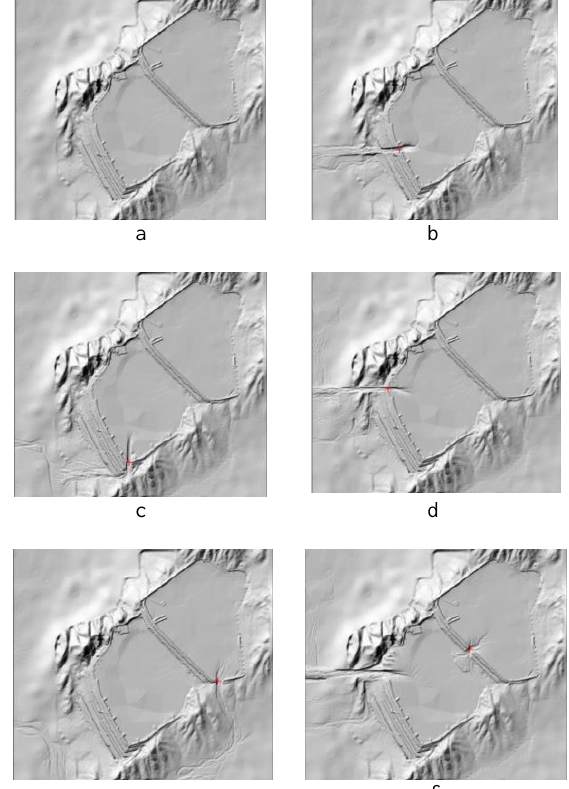
Figure 4. Structure of the passage in the tailings dump of the concentrating plant at the final stage of the hydrodynamic accident in various models. The position of the control points is shown by the red symbol: a) initial state, b) model 1a, c) model 1b, d) model 1c, e) model 2, f) model